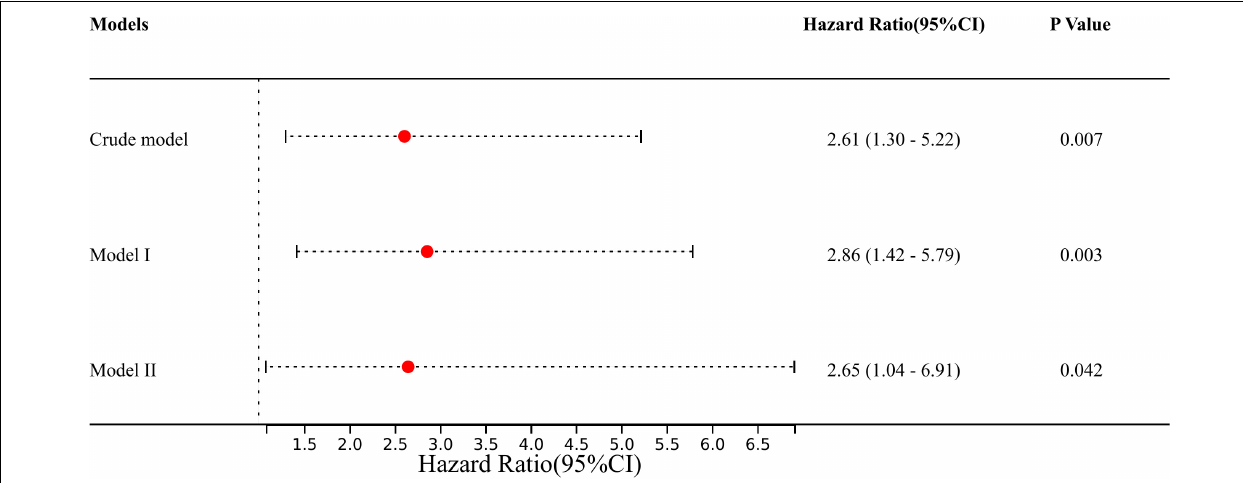
FIGURE 3 | The effect of obesity on outcomes following multivariable analysis based on the Cox proportional-hazard model. Crude model: adjusted for none. Model I: adjusted for: gender and age. Model II: adjusted for gender, age, SBP, DBP, heart rate, pre-operative delirium, LEVF 20–40%, time of ventricular fibrillation during surgery, aortic valve replacement, CABG, post-operative PLR, post-operative NLR, renal replacement therapy, and stroke. SBP, systolic blood pressure; DBP, diastolic blood pressure; LEVF, left ventricular ejection fraction; CABG, coronary artery bypass graft; PLR, platelet lymphocyte ratio; NLR, neutrocyte lymphocyte